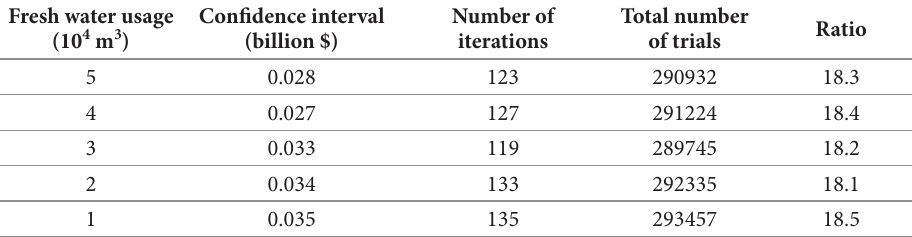
Table 8. Number of iterations, the total number of Monte Carlo trials used for optimal solution finding, the ratio of the total number of trials to the number of trials taken at the last iteration by the limit on the fresh water usage